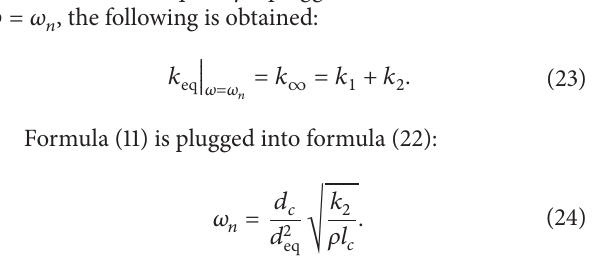
Table 1: Law by which 𝑘